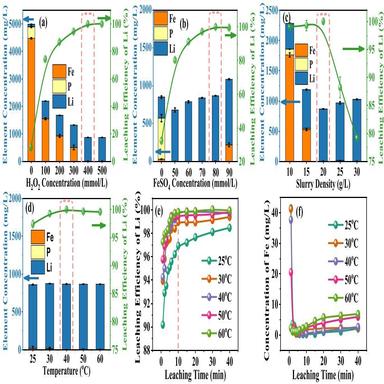
Different effects of (a) H2O2 concentration, (b) FeSO4 concentration, (c) Slurry density, and (d) Reaction temperature on dissolution of main elements (Fe, P and Li) in lixivium; effects of reaction temperature and leaching time (e)-(f) on the leaching of Li and Fe under the optimized leaching conditions of 400 mmol/L H2O2, 80 mmol/L FeSO4 and 20 g/L (initial pH solution is 2.1 configured from phosphoric acid). (Pink dashed rectangle: the optimized experimental conditions).